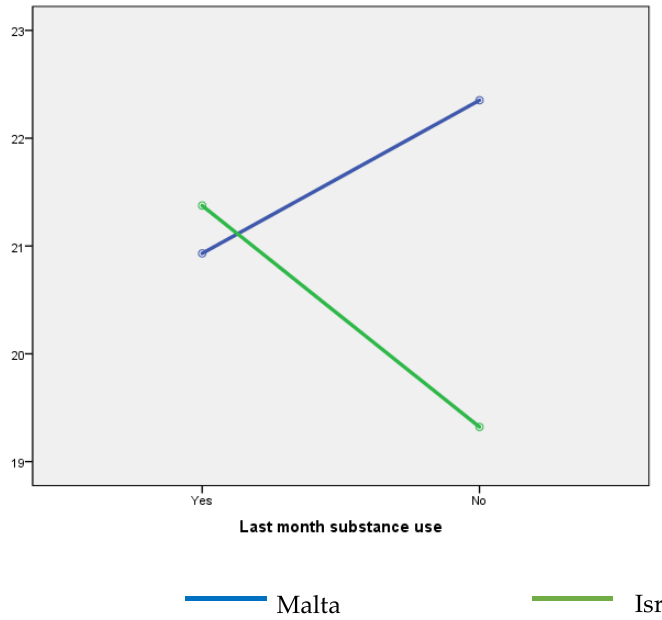
Figure 2. Fear of COVID-19 by country and previous-month substance use.